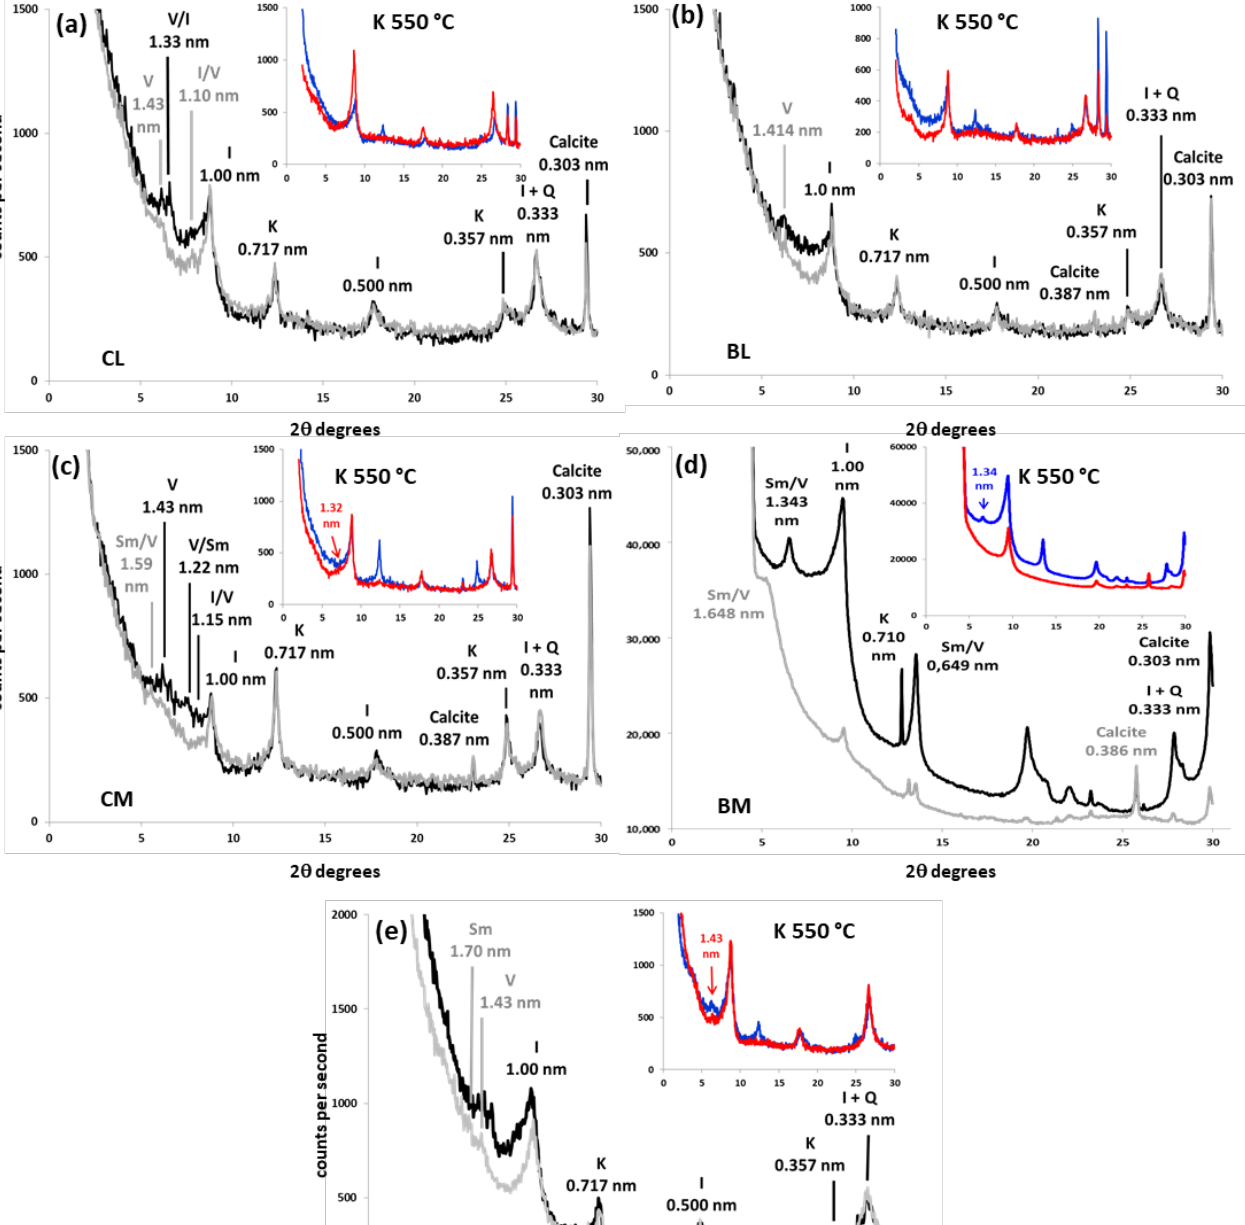
Figure 1. XRD patterns of oriented mounts (3 – 30°C 2θ) from clay fraction of the calcareous soils with different treatments (black: Mg-saturated and air dried; grey: Mg-saturated and EG-solvated; blue: K-saturated and air dried; red: K-saturated and heated at 550 °C). ( a ) Cover-crop soil over limestone colluvia (CL); ( b ) bare soil over limestone colluvia (BL); ( c ) cover-crop soil over marls (CM); ( d ) bare soil over marl (BM); ( e ) woodland soil over limestone colluvia (WL). Q: quartz; Sm: smectite; Sm/V: smectite–vermiculite mixed layer; V/Sm: vermiculite–smectite mixed layer; V: vermiculite; V/I: vermiculite–illite mixed-layer; I/V: illite–vermiculite mixed-layer; I: illite; K: kaolinite.